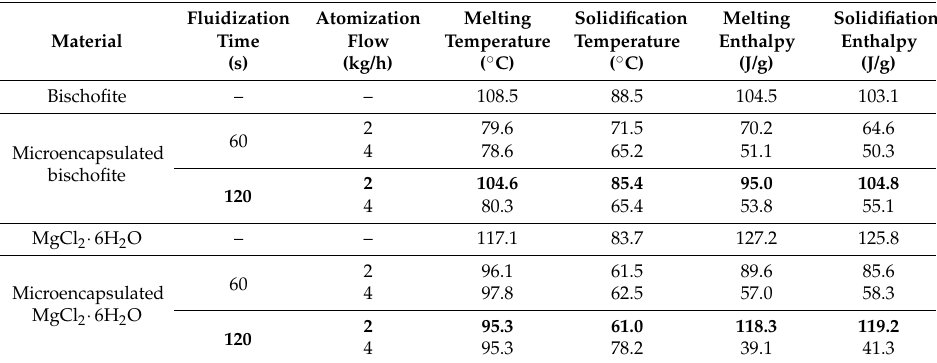
Table 5. Thermal characterization of microencapsulated PCM.